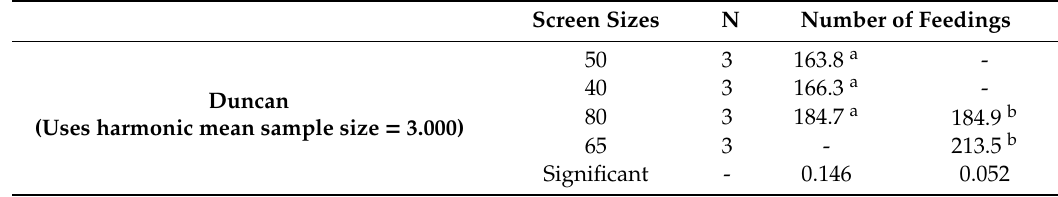
Table 5. Duncan’s multiple range test for the number of feedings per hour on screen size. n = 12. Screen Sizes N Number of Feedings